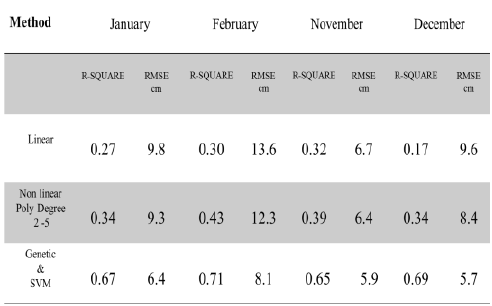
Table 1. Results of linear, nonlinear and genetically-SVM snow depth retrieval models in different snowfall